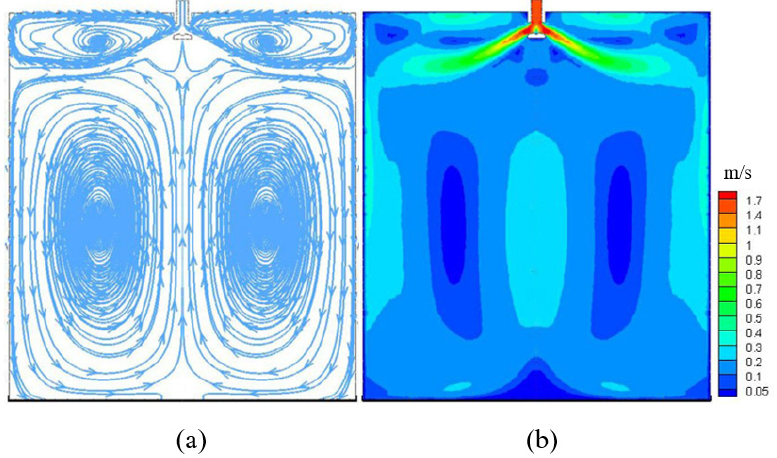
Figure 13. Fluid contours: ( a ) trajectory line; and ( b ) flow field at a 2500 mm width.